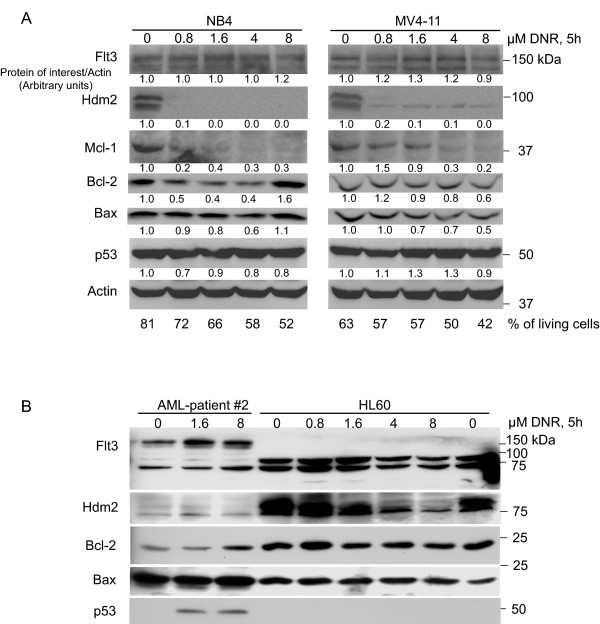
Daunorubicin therapy of primary AML cells and cell lines increased Flt3 protein and attenuated Hdm2/Mcl-1. A. Treatment of NB4 and MV4-11 cells with DNR resulted in an increase in Flt3 and a decrease in Hdm2. The mean intensity on one representative Western blot was calculated and normalized to Actin and to the control. The numbers shown are in arbitrary units and represent one typical experiment. The percentage of living cells was determined by flow cytometry. The living cells distinct forward and side scatter properties were used to separate viable cells from dead cells. B. Increasing doses of DNR induce Flt3 and down regulate Hdm2 protein in primary AML cells in vitro. Note that Hdm2 is down regulated in HL-60 cells, a cell line with lack of full length Flt3 protein and with deleted alleles for p53. All wells on the SDS-PAGE gel was loaded with equal amounts of protein, and Coomassie staining of the gel after blotting confirmed this equal loading.